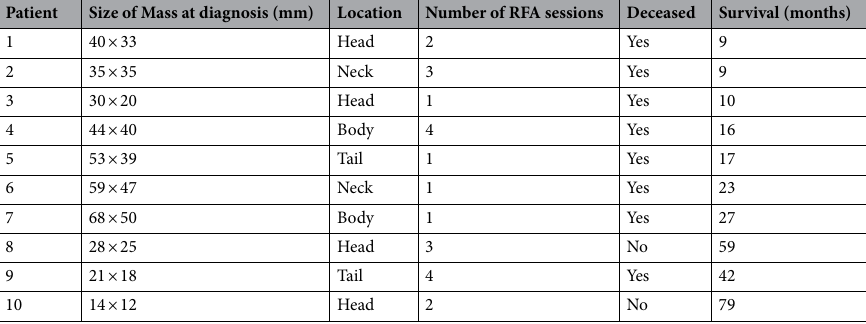
Table 2. Characteristics of pancreatic lesions, number of RFA sessions and overall survival in patients undergoing EUS-RFA (include survival from 1st RFA).